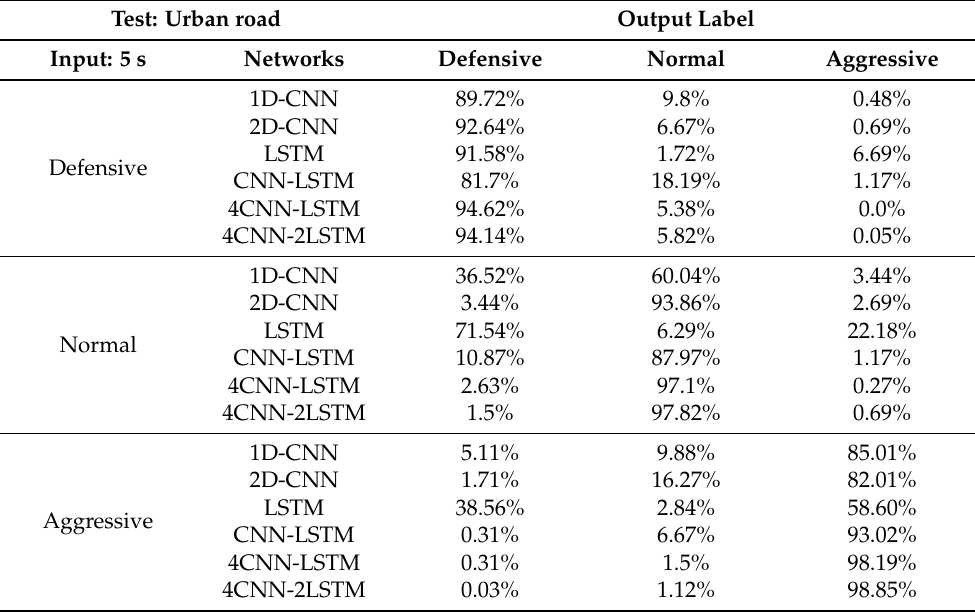
Table 7. Confusion matrix of urban road driving behavior classification results in simulation.